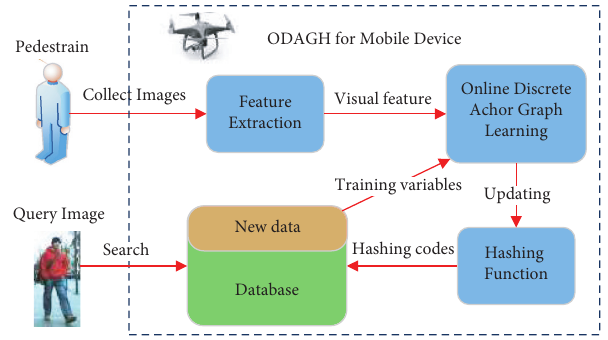
Figure 1: The overall framework of OAGH for mobile person re-id. Table 1: Summary of main